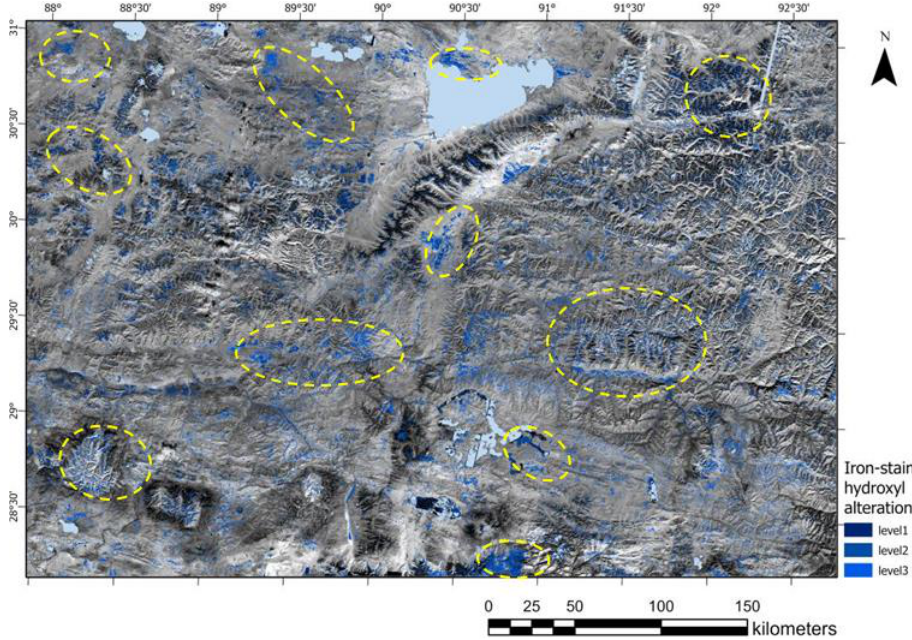
Figure 11. Iron-stained alteration map of the Gondwana region obtained by the EPCA method. (The yellow dashed boxes in the figure indicate the more pronounced spatial aggregation of alteration information.)